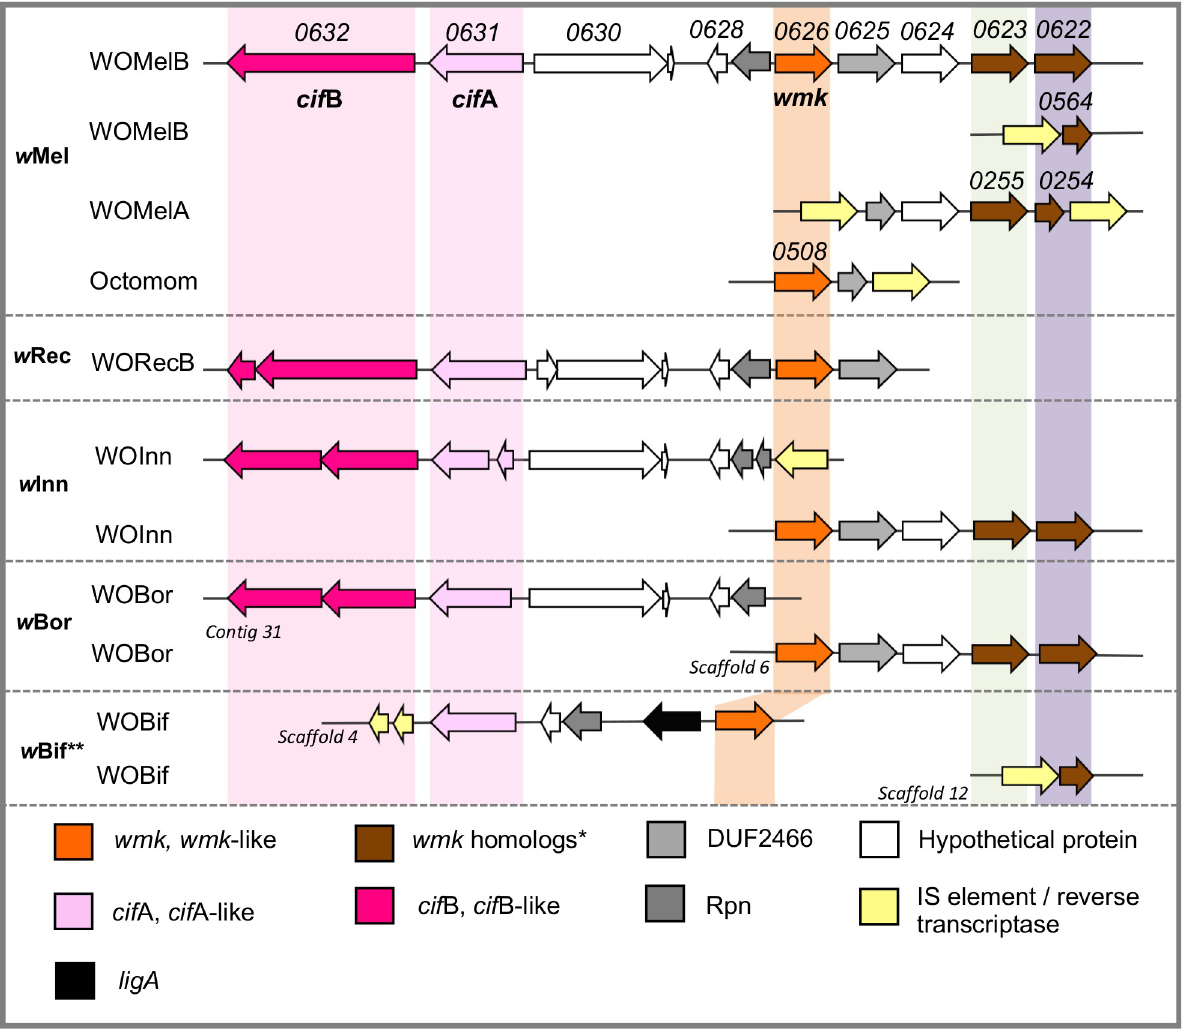
Fig 1. Comparative genomics of wmk and its homologs in w Mel and male-killing strains. Prophage WO gene regions containing wmk , wmk -like homologs, and CI genes cif A and cif B are listed by Wolbachia strain in bold and then prophage. At least one wmk homolog is associated with each Wolbachia -induced male killing strain. Genes pointing in the same direction are on the same DNA strand. The distance between wmk and cif A is approximately 5 kb. Shading highlights homologs in each strain. ( � ) wmk homologs are annotated as transcriptional regulators in the Wolbachia reference genomes and encode helix-turn-helix XRE domains (S4 Table). ( �� ) While w Bif reportedly induces weak CI after temperature treatment [8], the assembled genome does not contain cifB .